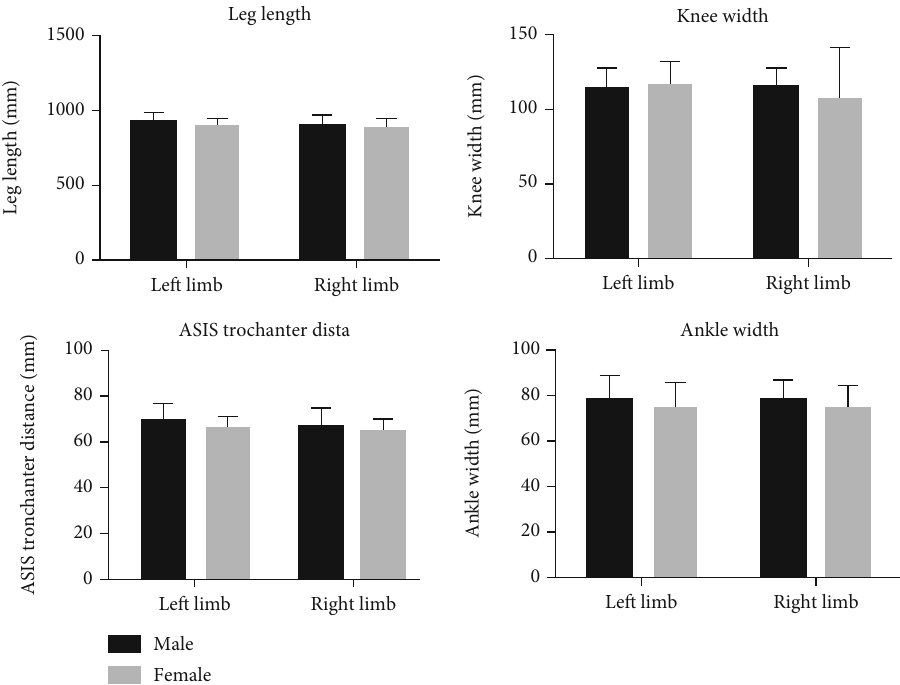
Figure 3: Grouped bar chart representation of the anthropometric datasets with respect to sidedness and X -axis of the hip joint for both limbs (left female: X = – 3 : 13 ° ± 5 : 01 ; left male: X = – 0 : 253 ° ± 2 : 436 ; right female: X = – 3 : 2 ° ± 1 : 541 ; right male: X = – 0 : 356 ° ± 7 : 242 ). Bar chart